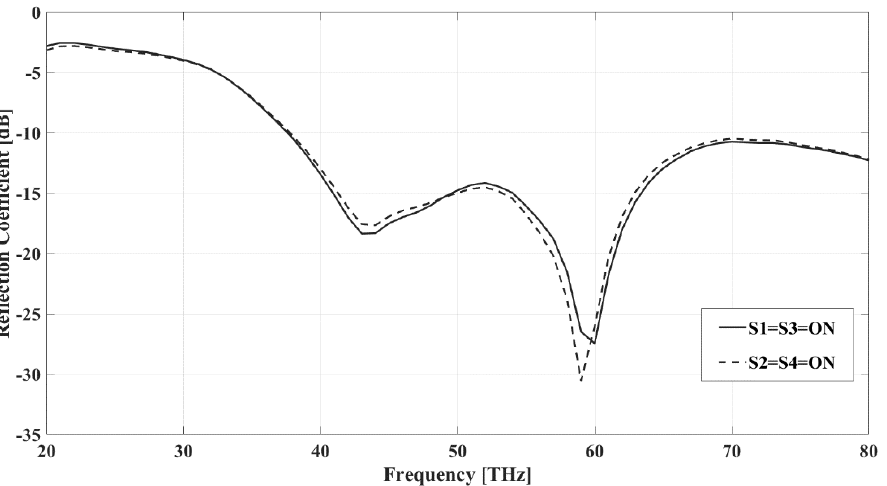
Figure 9. Reflection coefficient versus frequency when S2 = S4 = ON and S1 = S3 = ON. The simulations were done with the Sonnet Professional software.